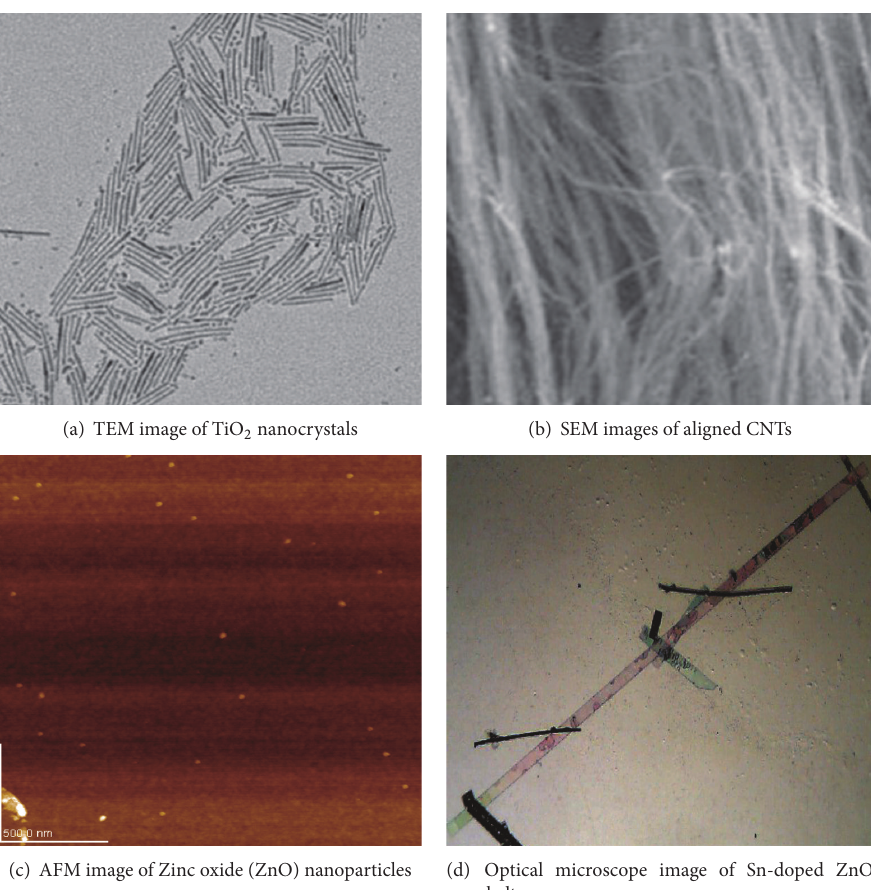
Figure 2: Examples of different types of nanomaterials including particles, crystals, tube, and